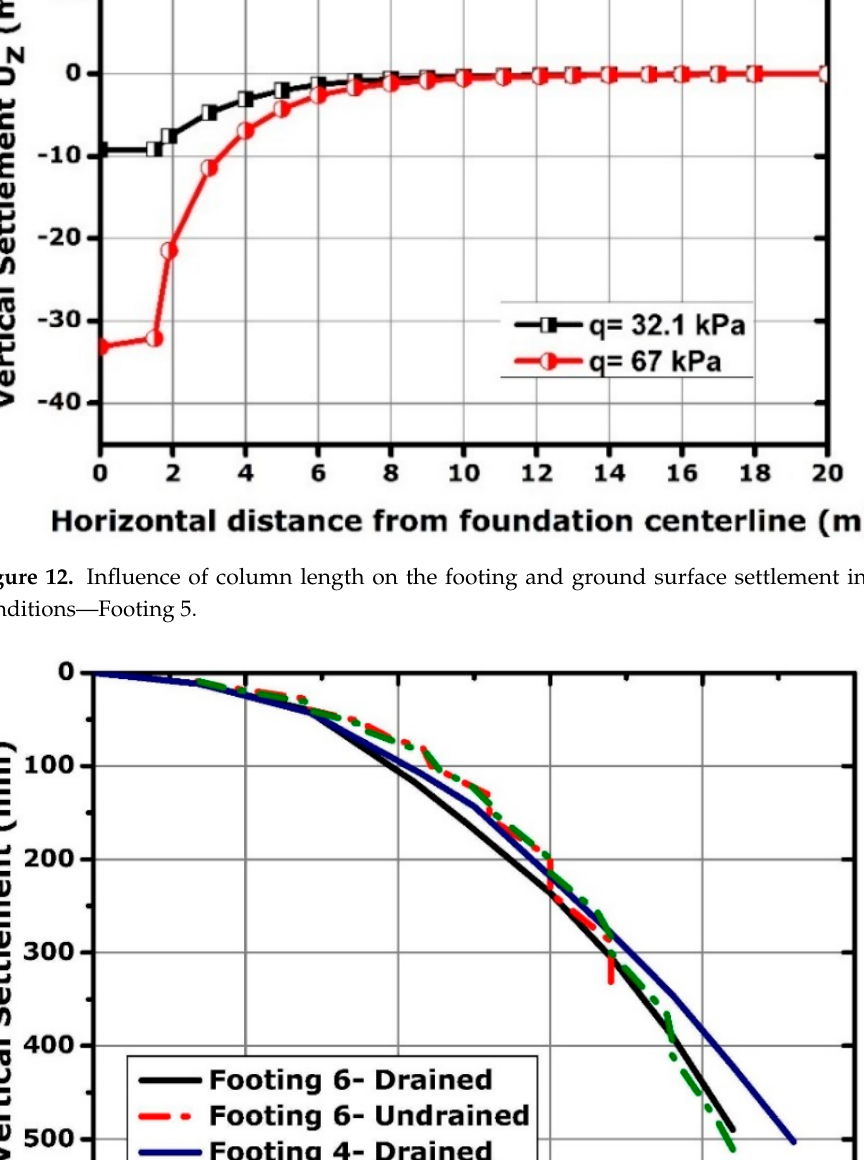
Figure 12. Influence of column length on the footing and ground surface settlement in drained conditions—Footing 5.